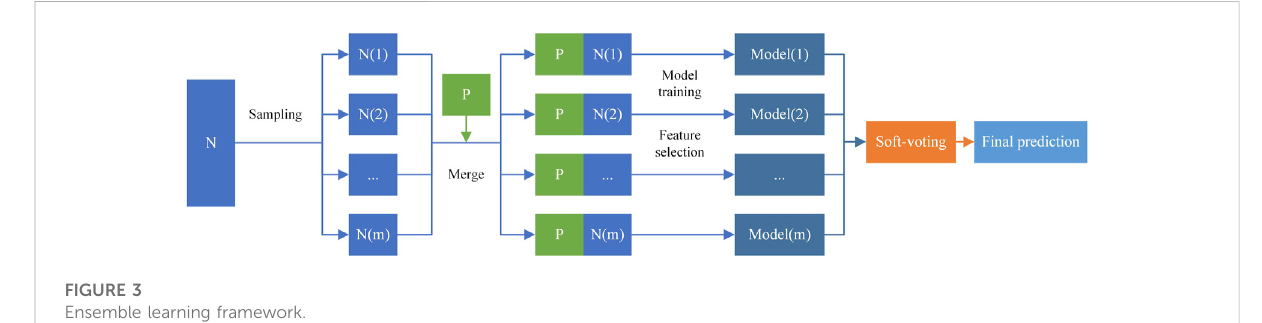
FIGURE 3 Ensemble learning